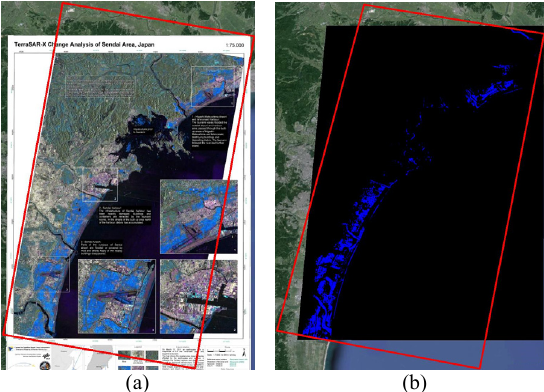
blue in the thematic map. (b) The detected flooded areas (blue) by using morphological approaches in this study. Both red squares indicate the range of the study